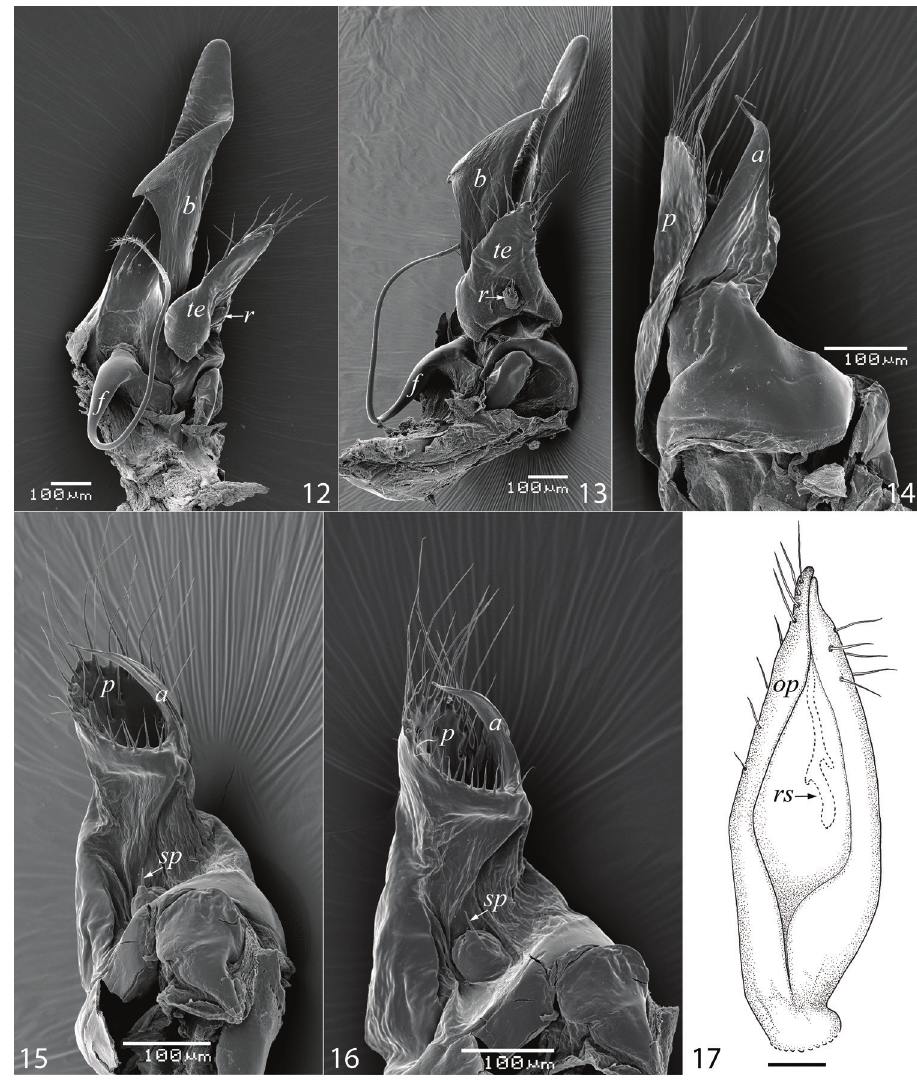
Figures 12–17. Skleroprotopus membranipedalis , gonopods and vulva: 12 left anterior gonopods, caudal, slightly lateral view 13 left anterior gonopod, lateral view 14 left posterior gonopod, lateral view 15 right posterior gonopod, antero-mesal view 16 same, mesal view 17 left vulva, lateral view. Symbols: a : ante- rior process, b : axe blade-like process, f : flagellum, op : operculum, p : posterior process, r : remnant of a podomere; rs : receptaculum seminis, , sp : basal spine, te : telopodite. Scale bar ( 17 ): 0.2 mm.